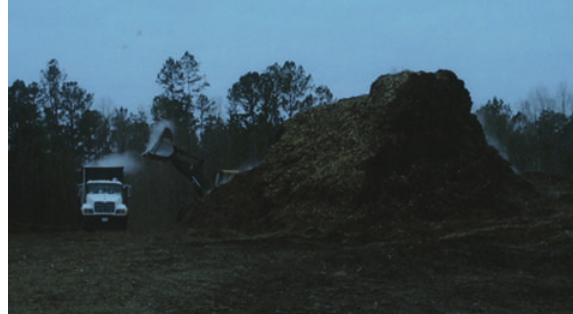
Figure 4: Smoldering chips in Lincoln County TDSRS in January